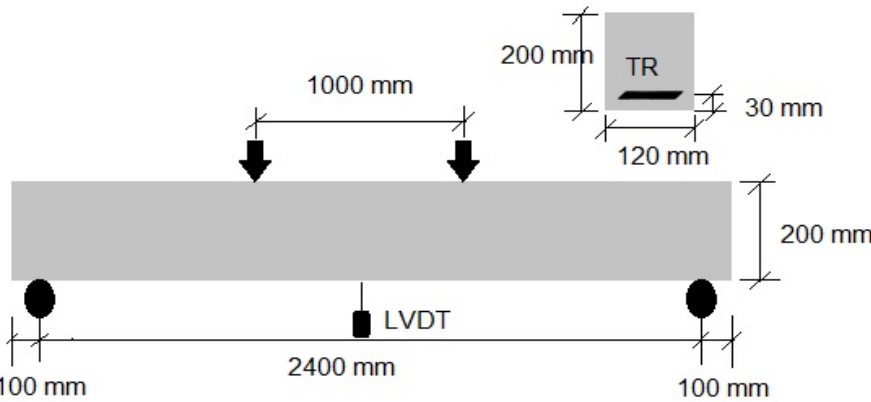
Figure 2. Four-point bending test set-up used for large-scale beams.